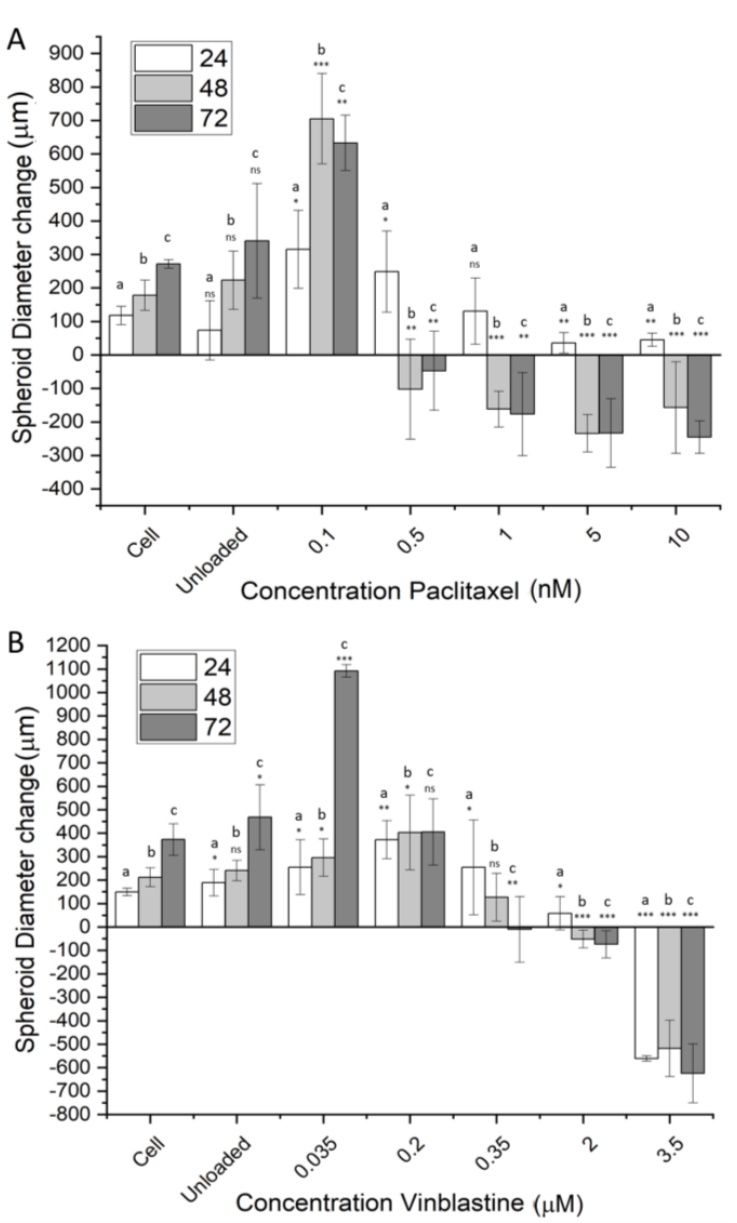
Figure 9. The effect of drug delivery by the NCC on spheroid models. Spheroid diameter changes from t = 0 in the presence/absence of varying concentrations of activated NCC–drug. ( A ) shows RD spheroid diameter change when paclitaxel is delivered by the NCC, and ( B ) shows the diameter change for U87-MG cells with the delivery of vinblastine. The change in diameter is shown over a period of 72 h. Diameters were measured using three dimensions of the radius and were performed in triplicate. Cells refer to the cell-only control and are set to 100%. All data are listed as spheroid diameter change in comparison to the diameter at t = 0. Significance was tested using a two-tailed t -test that compared between the sample and the cell control for that time point; a represents a comparison to 24 h, b to 48 h, and c to 72 h. p -values assessed are represented as follows *** = p < 0.01, ** = 0.05 < p > 0.01, * = 0.5 < p > 0.05, ns = p > 0.5. Bars represent mean +/ − standard deviation, n = 3. The spheroid models showed good biocompatibility for the unloaded NCC, as no significant cell death was seen with any cell line. The concentrations of the drugs delivered showed a reduction in spheroid diameter compared to the untreated control, exhibiting a level of penetration into the structure. Generally, spheroid diameter continued to reduce